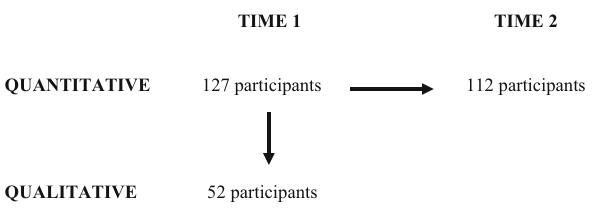
Fig. 2 Structure of the study sample in Amatrice, Central Italy, after the 2016–2017 earthquakes, divided according to method and